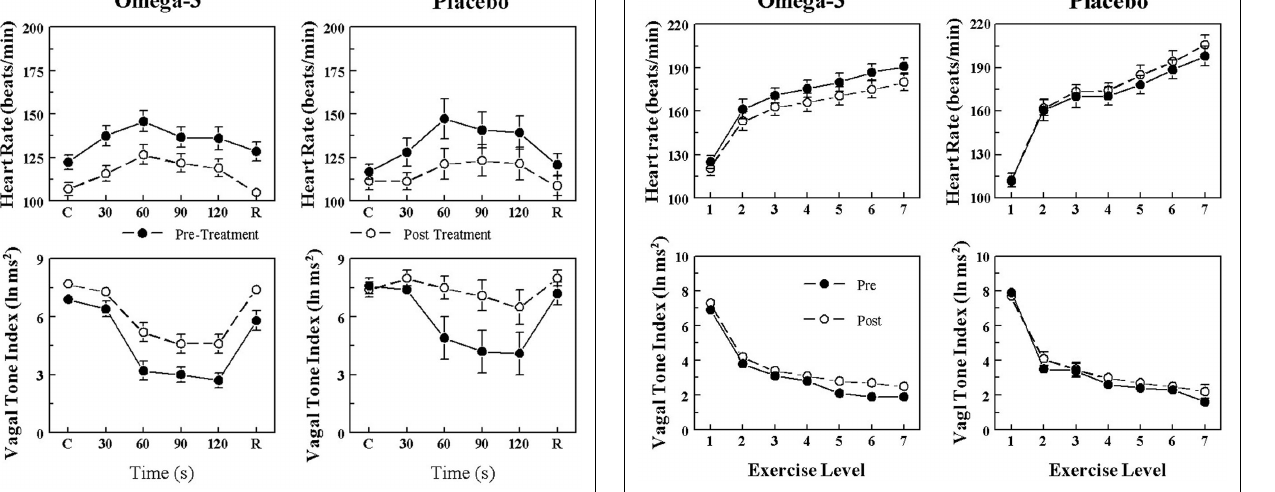
FIGURE 2 | Effect of omega-3 polyunsaturated fatty acids (n − 3 PUFAs) on the heart rate and heart rate variability response to acute myocardial ischemia (2min left circumflex coronary artery occlusion) in dogs resistant to ventricular fibrillation. Dietary n − 3 PUFA, but not